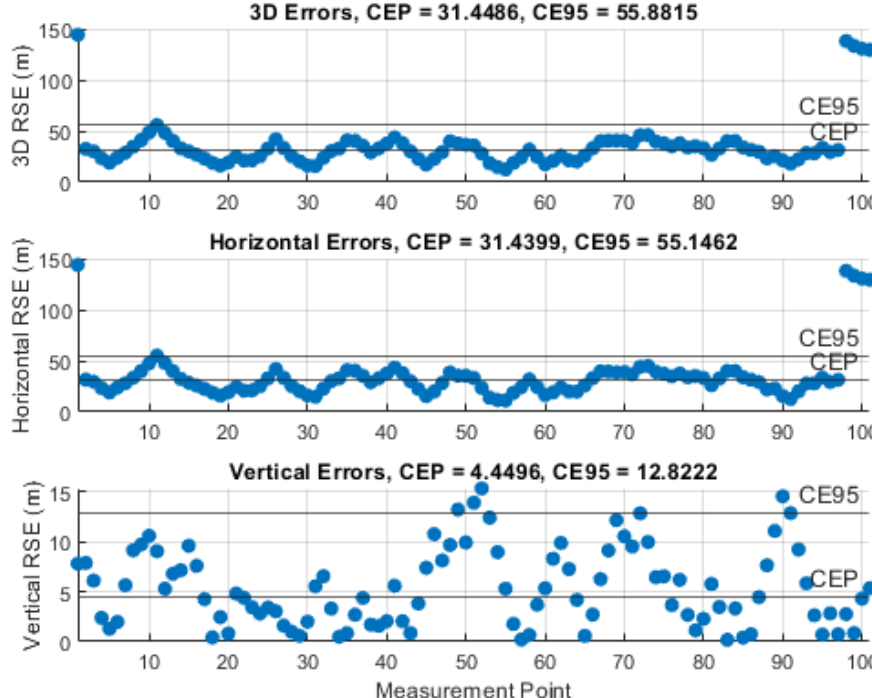
Figure 13. RSE evolution of the IPF solution with a measurement error SD, σ θ , ϕ , of 4 ◦ .